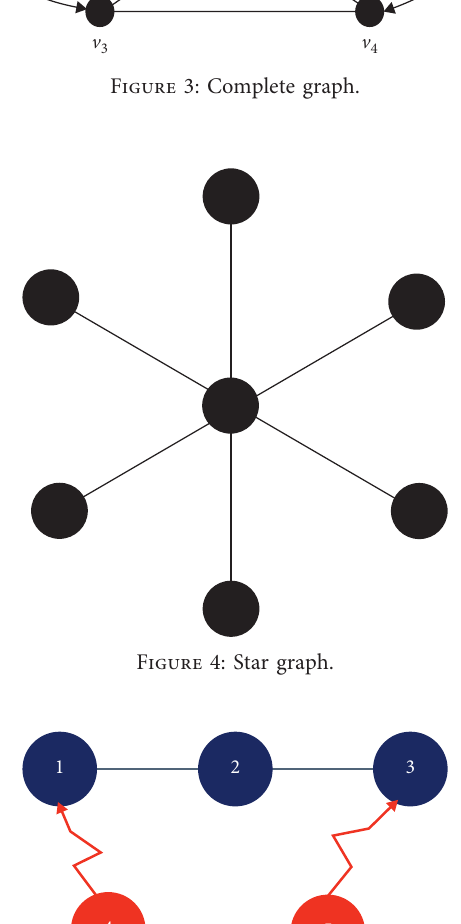
Figure 3: Complete graph.